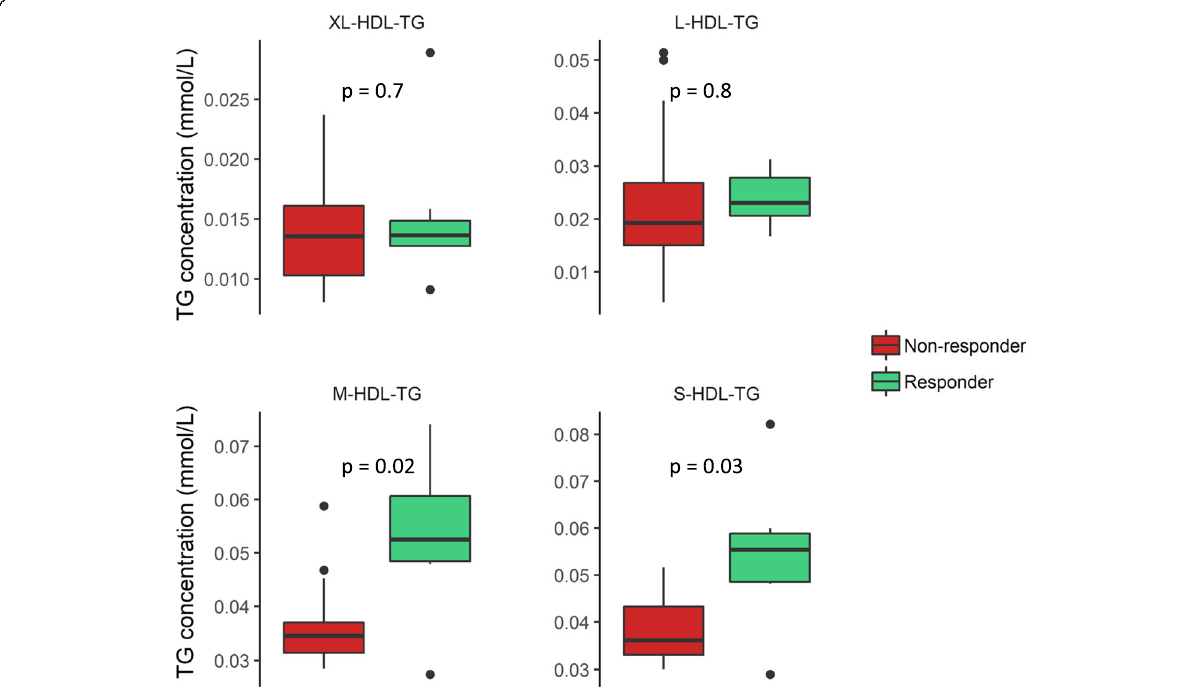
Fig. 2 Baseline triglyceride levels in HDL subclasses. The baseline TG levels in XL-, L-, M-, and S-HDL subclasses (mmol/L) in responders (green) and non-responders (red). Differences are tested on log 2 -transformed data with an independent t